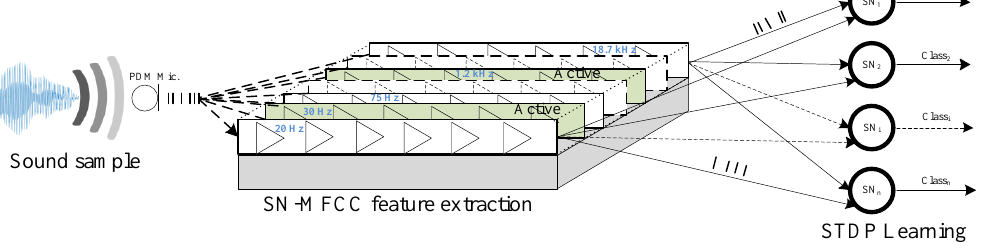
Figure 9. SN-MFCC based sound classification framework